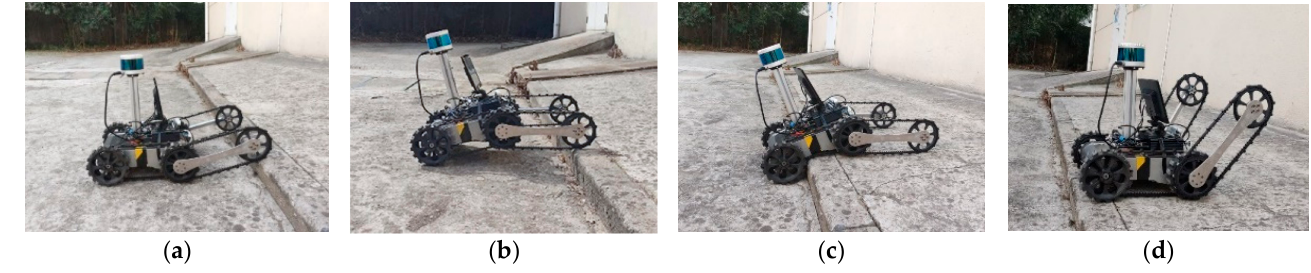
Figure 11. Robot climbing up steps: ( a ) lift the rocker arm; ( b ) track wheels against the step; ( c ) centroid crossing the step; ( d ) car body over the step.